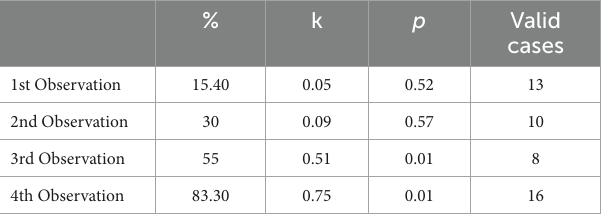
TABLE 1 Preliminary observations for validating the observation